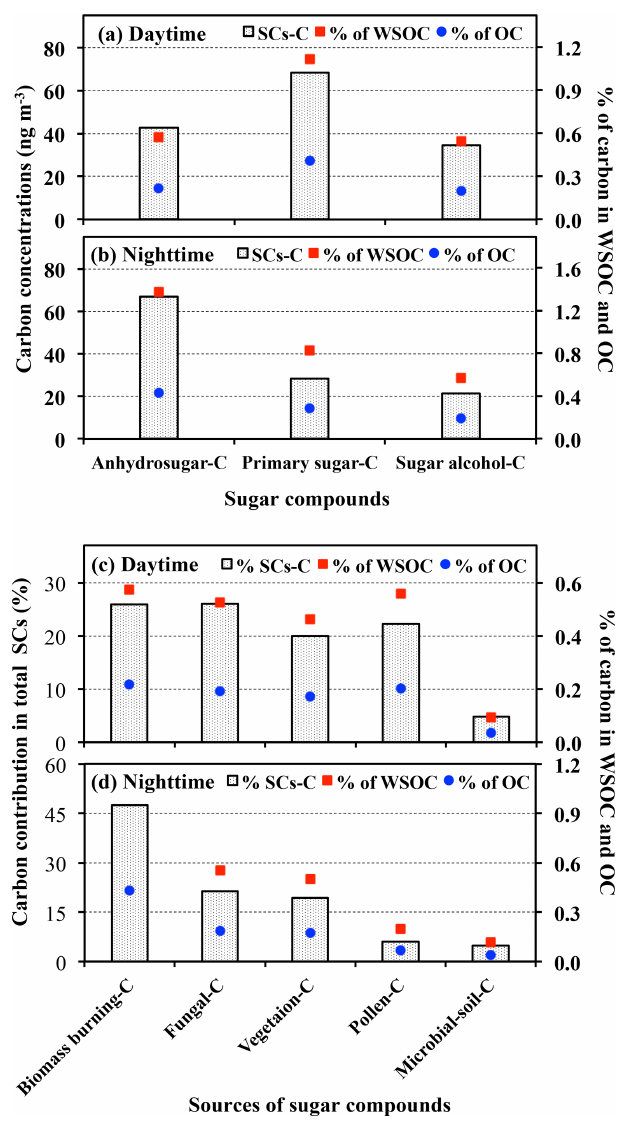
Figure 9. The concentrations and relative contributions of the car- bon content of anhydrosugars, primary sugars, and sugar alcohols to the carbon concentrations of measured sugar compounds, water- soluble organic carbon (WSOC) fraction, and organic carbon (OC) fraction of Mangshan aerosols ( a : daytime; b : nighttime). The con- centrations and relative contribution of the carbon content of five sources of sugar compounds to total sugar compounds measured, WSOC fraction, and OC fraction of Mangshan aerosols ( c : daytime; d :